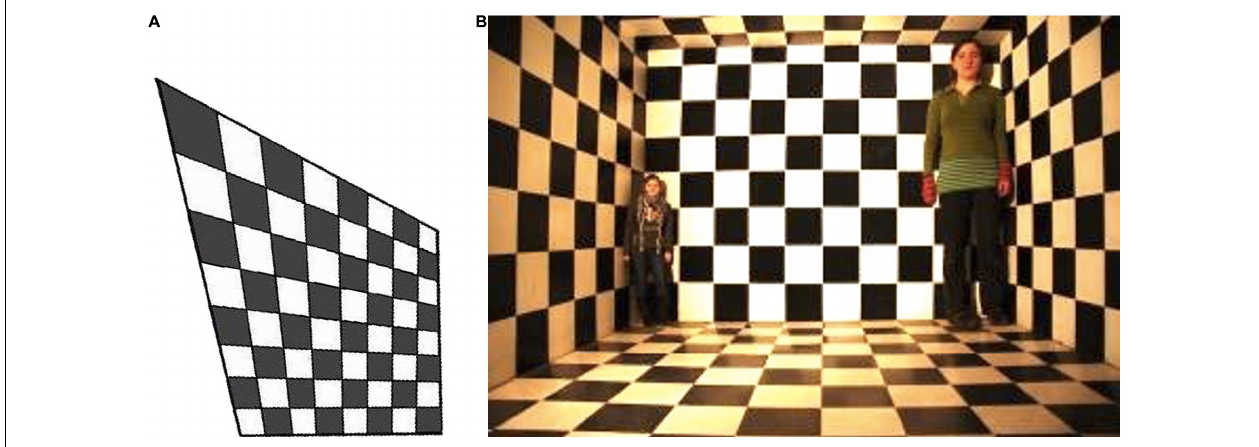
FIGURE 2 | (A) The construction geometry of the Ames Room illusion. (B) A checkerboard version of the illusion, showing the apparent size difference between two people of equal height induced by the normalization assumption that the checks are physically rectangular. The illusion can be revealed by the operation of asking the two people to exchange places. Image credit: